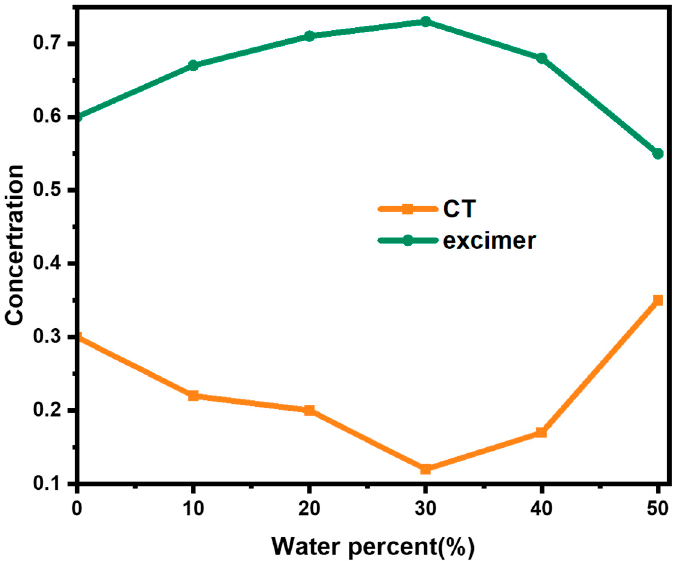
Figure 7. Concentration variations of the CT and excimer states at different water